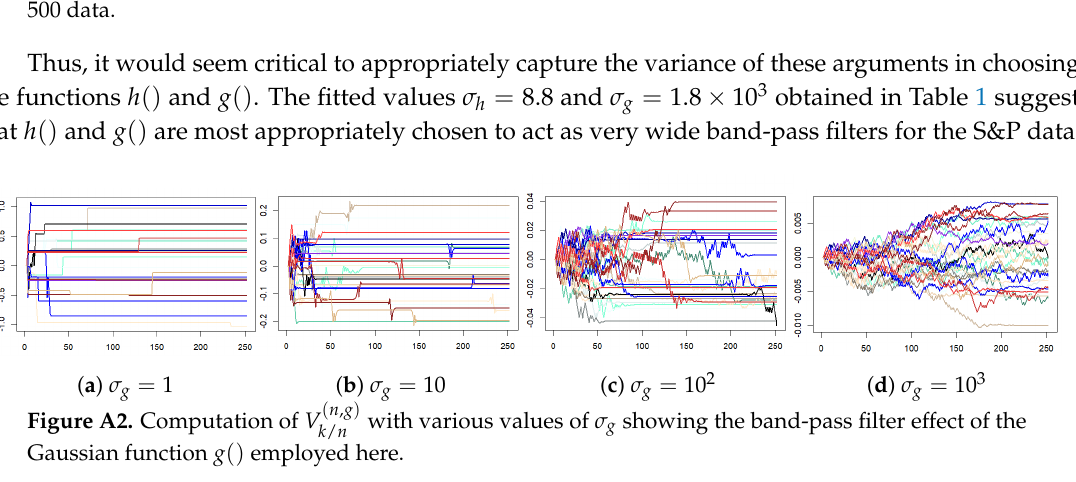
( n , g ) ( n , h , g , S ) ( n ) ( n , h ) , Y , V , and S computed from the S&P k ∆ t k / n k / n k / n